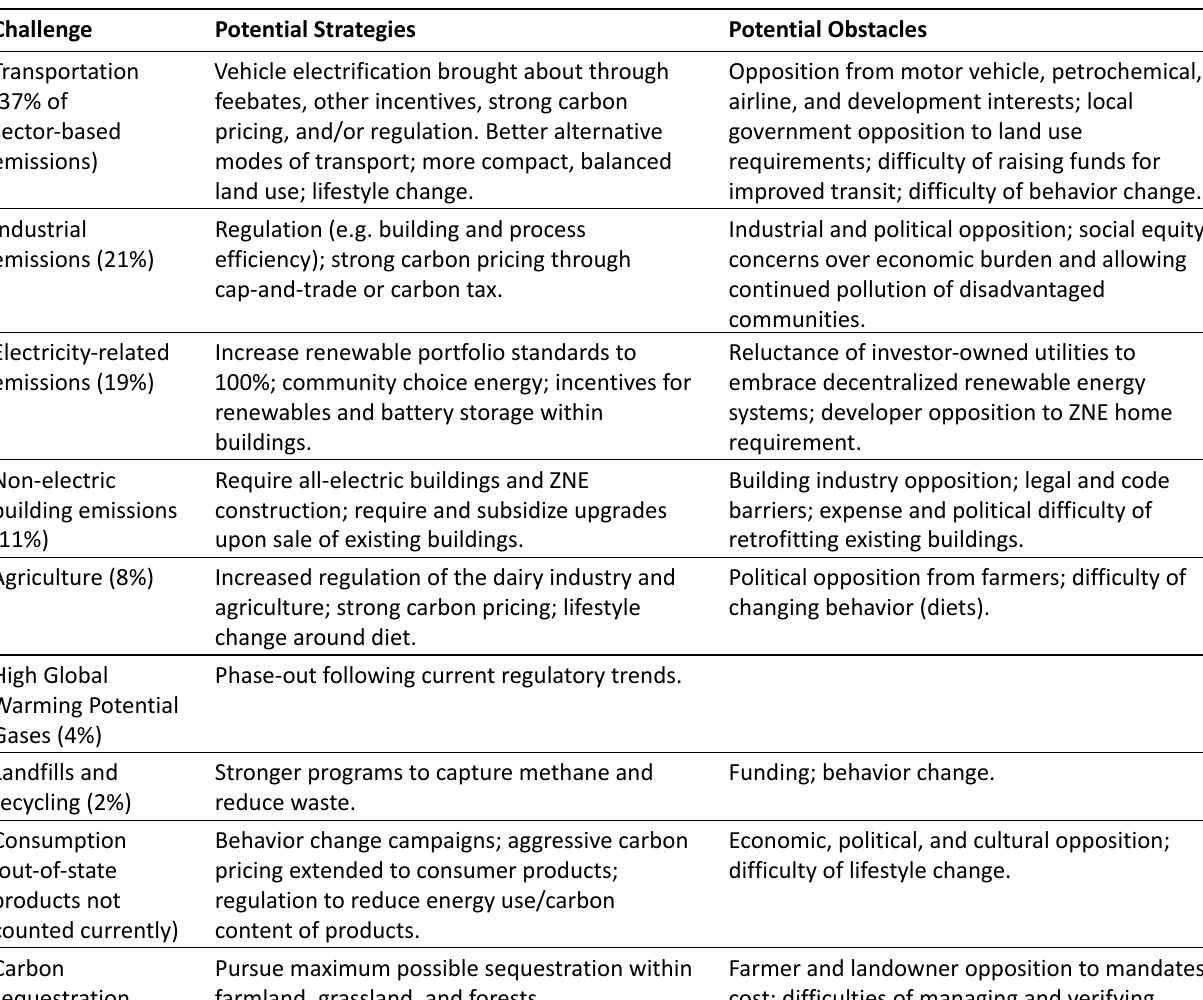
Table 1. Carbon neutrality policy strategies and obstacles. Emission percentages retrieved from CARB,